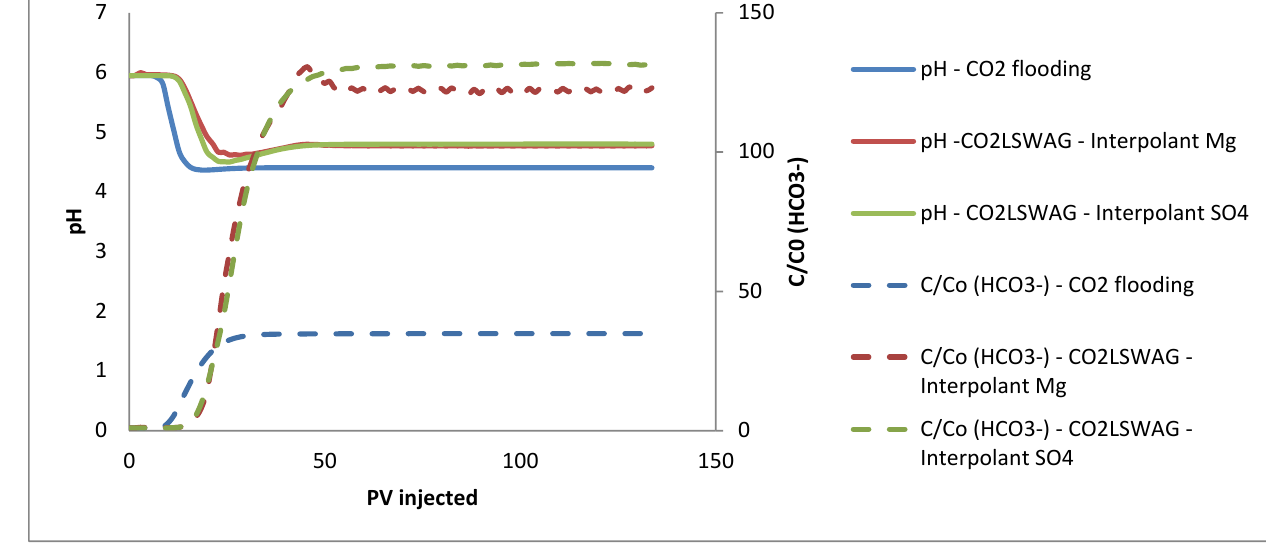
Figure 11. Results of pH and HCO 3 − concentration in the effluent for continuous CO 2 injection and CO 2 -LSWAG considering Mg and SO 4 as ion interpolants.